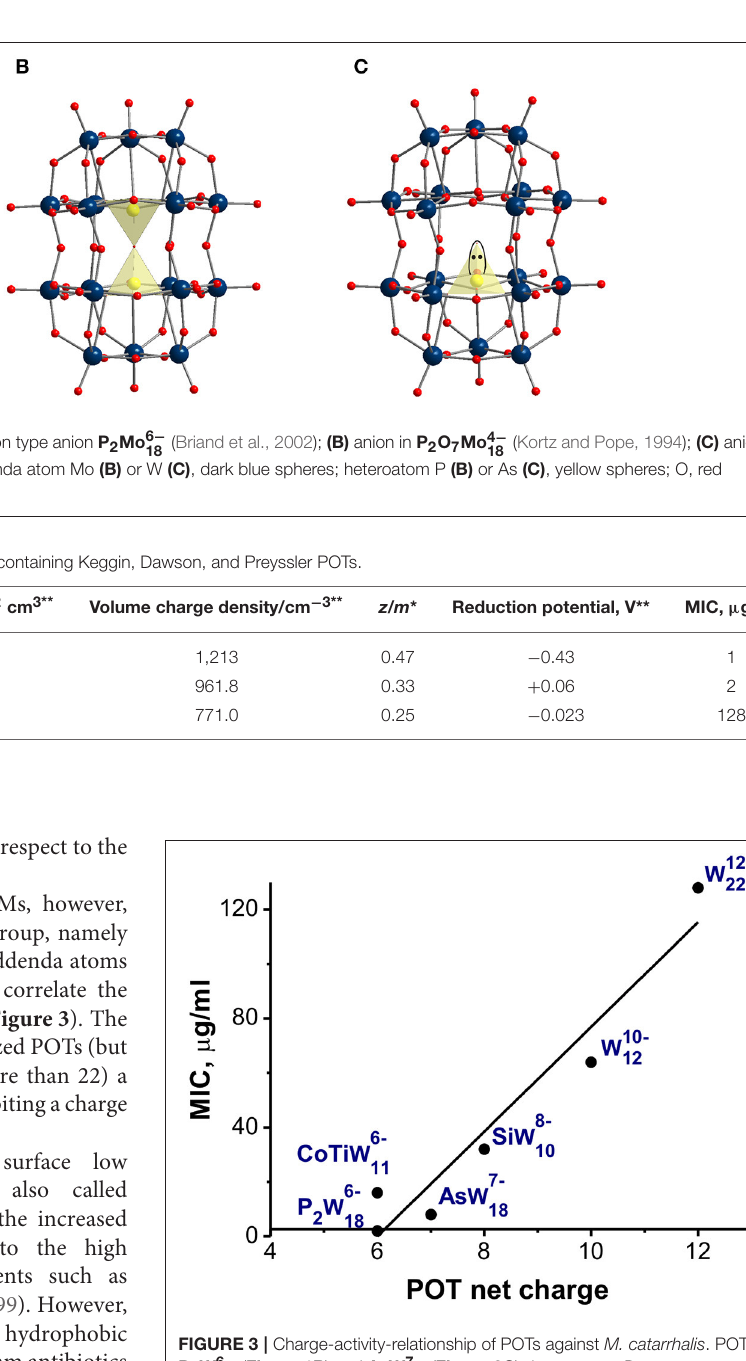
FIGURE 3 | Charge-activity-relationship of POTs against M. catarrhalis . POTs P 2 W 6 − 18 ( Figure 1B ) and AsW 7 − 18 ( Figure 2C ) demonstrate Dawson structure, CoTiW 6 − 11 ( Figure 1D ) and SiW 8 − 10 ( Figure 1E ) are Keggin-based anions, whereas W 10 − 12 ( Figure 1H ) and W 12 − 22 - isopolytungstates (see Table 1